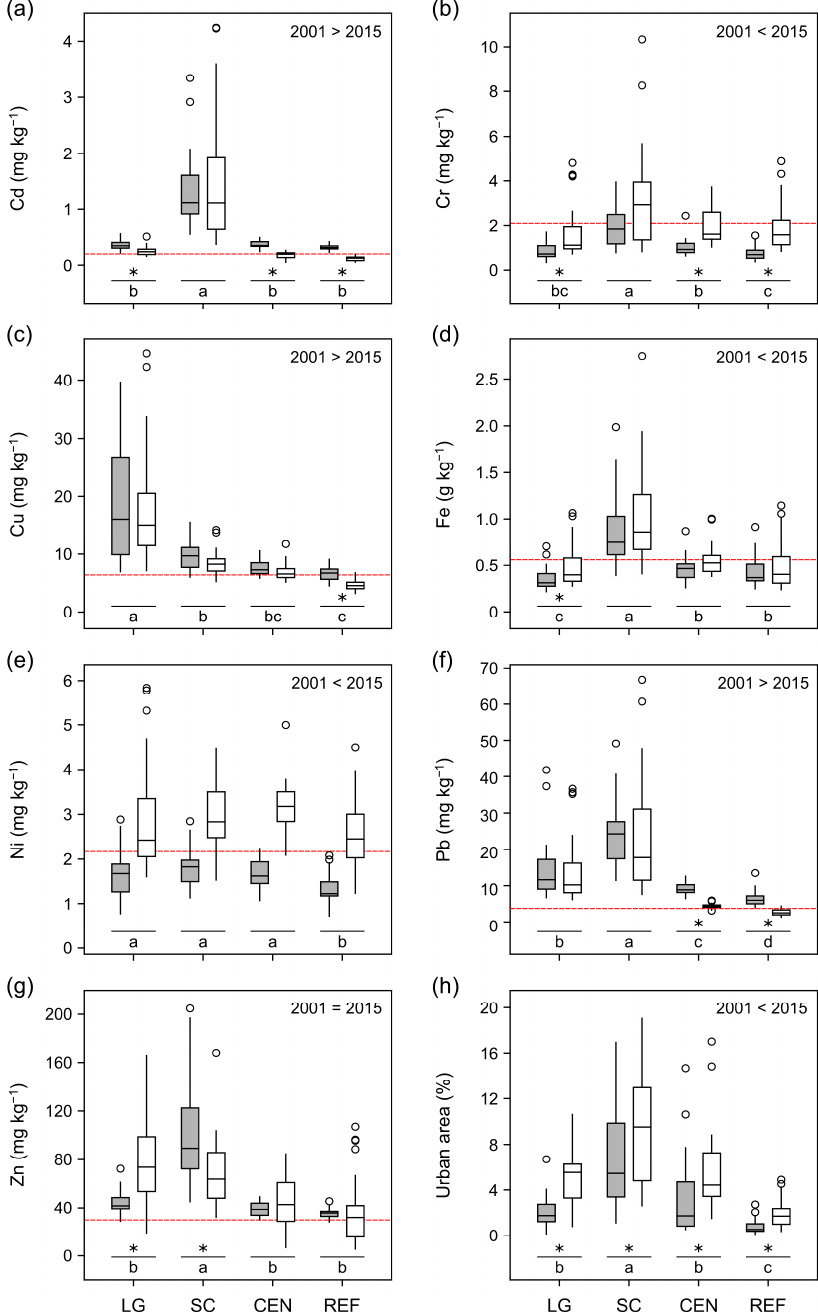
Figure 2. Changes in the concentration of trace metals in moss ( a – g ) and the percentage of the urban area ( h ) between 2001 (grey boxes) and 2015 (white boxes) in the four studied regions of Poland. Together with medians, quartiles, non-outlier range, and outliers (without extreme outliers) are shown. The red dashed-lines indicate the 2010 European median values [27]. The significant differences between years are marked with inequality expressions in the upper right corner of each panel, while the significant differences between regions are marked with different letters below the boxplots. Where there was a significant year × region interaction, the differences between years were tested separately for each region, and their statistical significance was denoted by asterisks. Between-group comparisons were performed (after significant LME results) using Tukey’s test (P < 0.05). Note that while the boxplots present original values, statistical analysis was performed on transformed data.